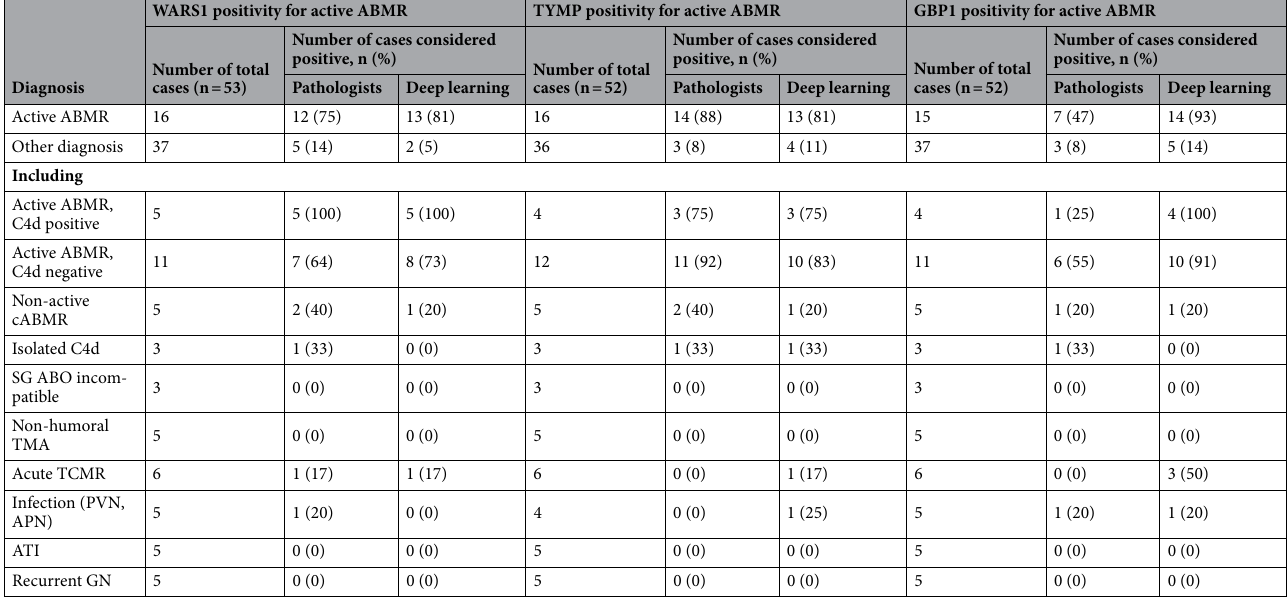
Table 3. Interpretation results of WARS1, TYMP and GBP1 antibodies by immunohistochemistry for predicting active ABMR by pathologists and deep learning. To easily compare pathologists and deep learning interpretations of the immunomarkers, a majority rule was applied on pathological interpretations, where each case was classified according to the report of most pathologists. In case of ties, the interpretation of the pathologist B.C. was retained. As for deep learning analysis, the three folds of one iteration of the cross- validation was used to classify samples. Please note that this iteration performance is logically slightly different than the average performance displayed in Table 3. Variations in total number of cases are due to insufficient remaining material for interpretation. ABMR Antibody-mediated rejection, WARS1 Tryptophan–tRNA